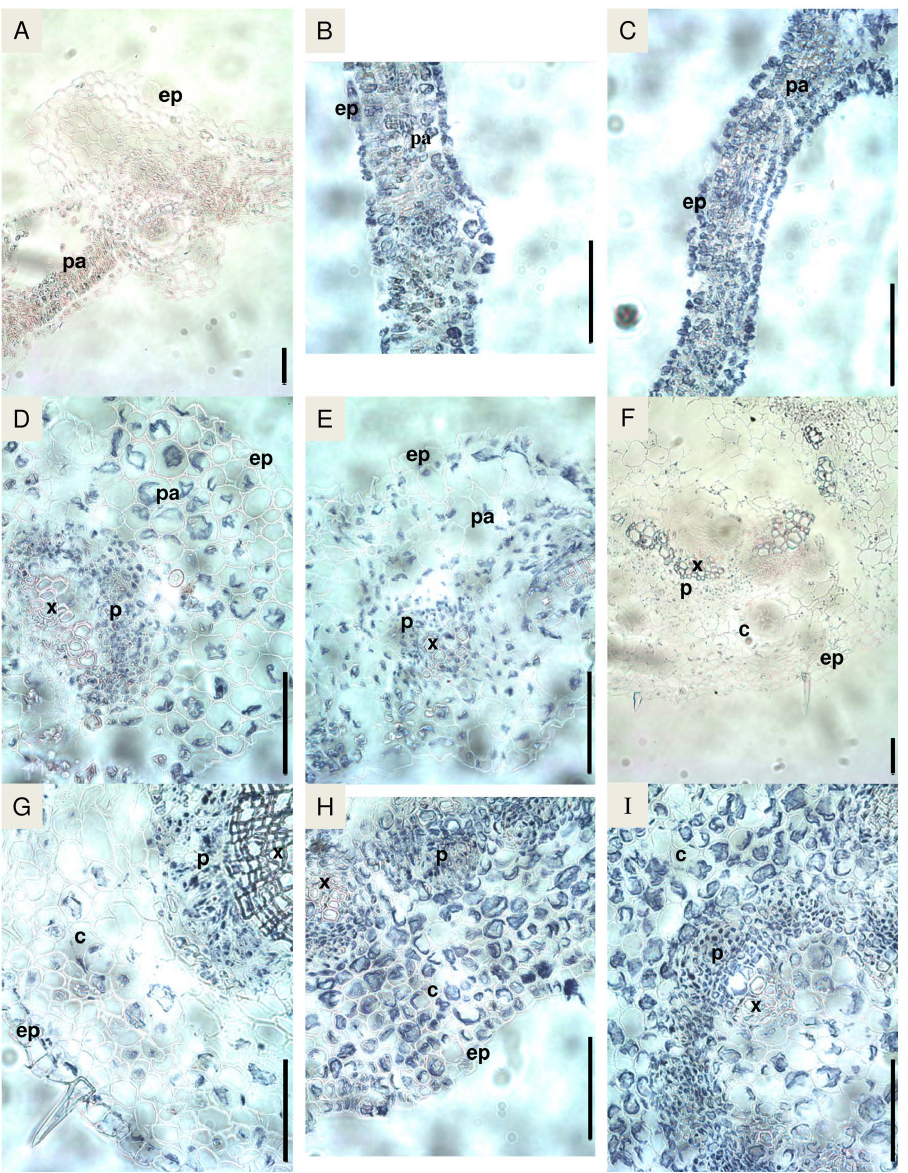
Figure 5. Immunolocalization of PttTrHb protein in hybrid aspen leaves and stem. A, Negative control obtained with leaf section incubated with primary antibody preabsorbed with the recombinant PttTrHb. B, Transversal section (TS) of young leaf from plant grown in normal conditions. C, TS of young leaf from 5 h SNP-treated plant. D, TS of mature leaf from plant grown in normal conditions. E, TS of mature leaf from 5 h SNP-treated plant. F, Negative control obtained with stem section incubated with primary antibody preabsorbed with the recombinant PttTrHb. G, TS of stem from plant grown in normal conditions. H and I, TS of stem from 5 h SNP-treated plant. c: cortex, ep: epidermis, p: phloem, pa: parenchyma, x: xylem. Bar = 100 m